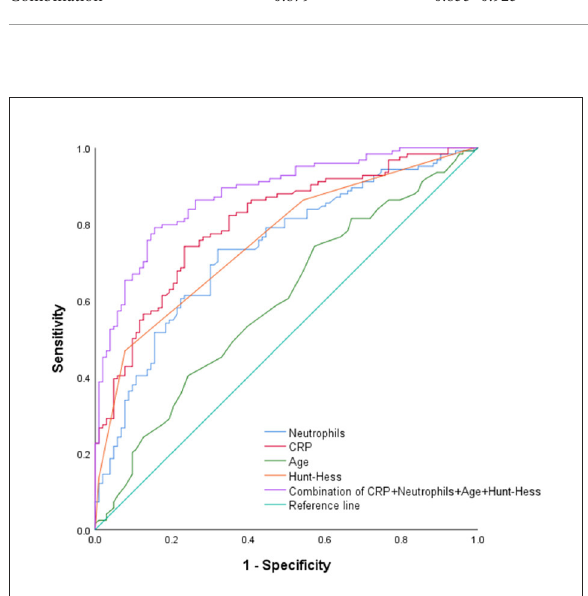
FIGURE7 ROC curve (Based on good prognosis group, poor prognosis